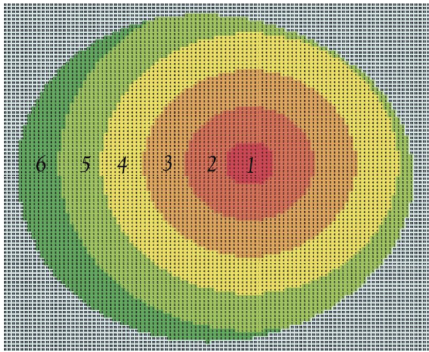
Figure 1: Corneal thickness segmentation scheme into virtual circular zones concentric with the corneal apex (1 to 6 denote zone I to zone VI,